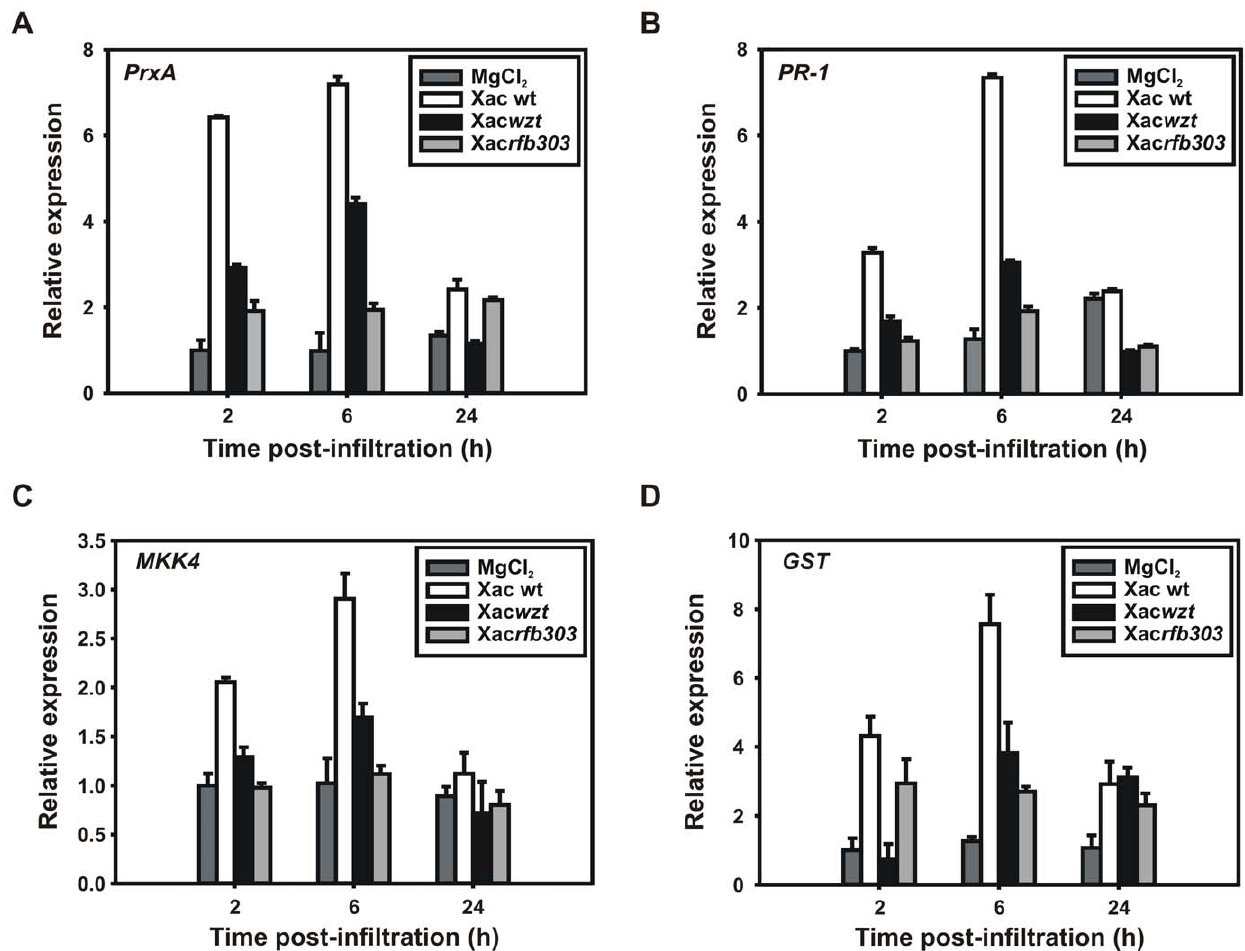
Figure 8. Expression analysis of C.sinensis defense-related genes. (A) Real Time PCR showing expression levels of PrxA , PR-1 , MKK4 and GST genes from orange leaves infiltrated with Xac wild-type, Xac wzt and Xac rfb303 at 10 7 CFU ml 2 1 and 10 mM MgCl 2 as control. Leaves were harvested at 2, 6 and 24 hpi. Columns show the expression value relative to the control. To perform the analysis of relative expression we used the 2 2 DD CT method normalizing to actin expression levels. The results are expressed as mean 6 standard deviation of three independent determinations.